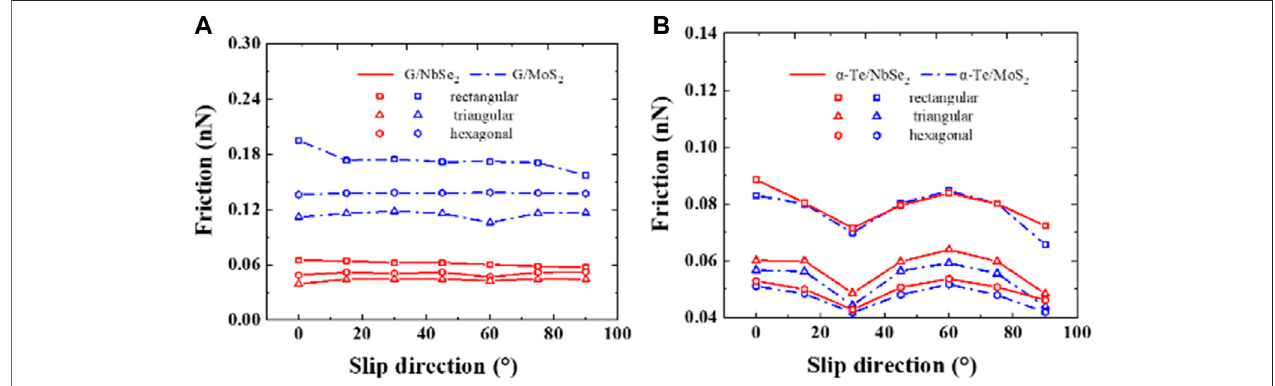
FIGURE 13 | Effect of slide direction on interlayer friction. The shape of the data points represents the shape of the slider in the simulation, which are rectangular, triangular, and hexagonal. (A) graphene/MoS 2 and graphene/NbSe 2 ; (B) α -Te/MoS 2 and α -Te/NbSe 2 .